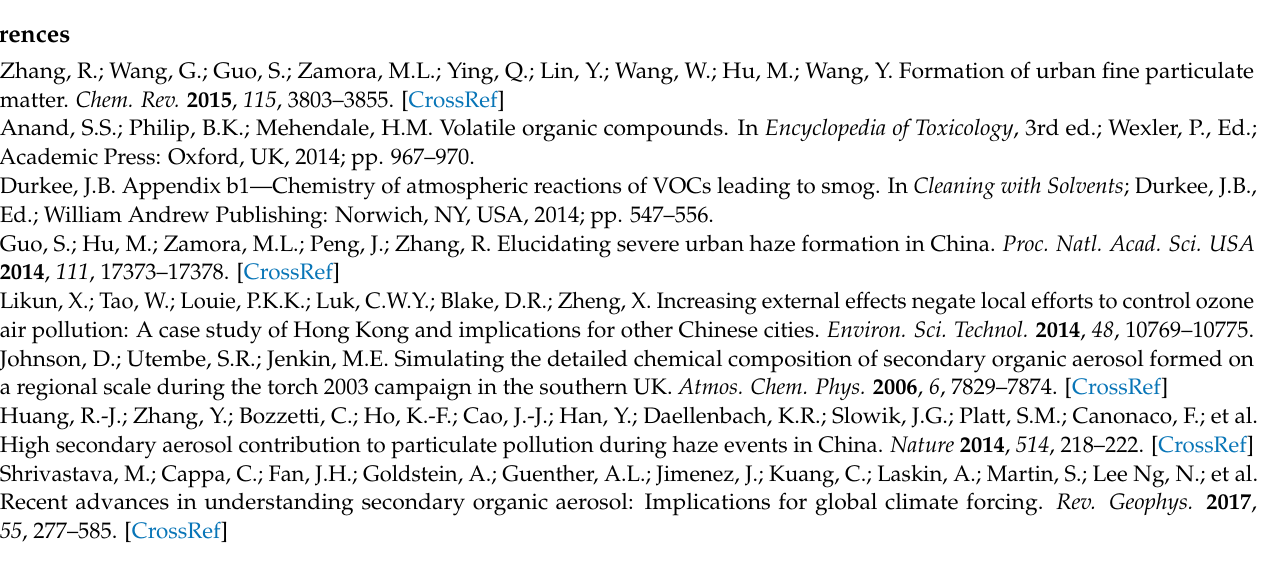
sites, Figure S2: Factor profile resolved by PMF at the ZH((a) in control, (b) deregulation), DSL((c) in control, (d) deregulation) and YX((e) in control, (f) deregulation) sites during different periods of the G20 summit, Table S1: Control measures during different control phases in Shanghai and